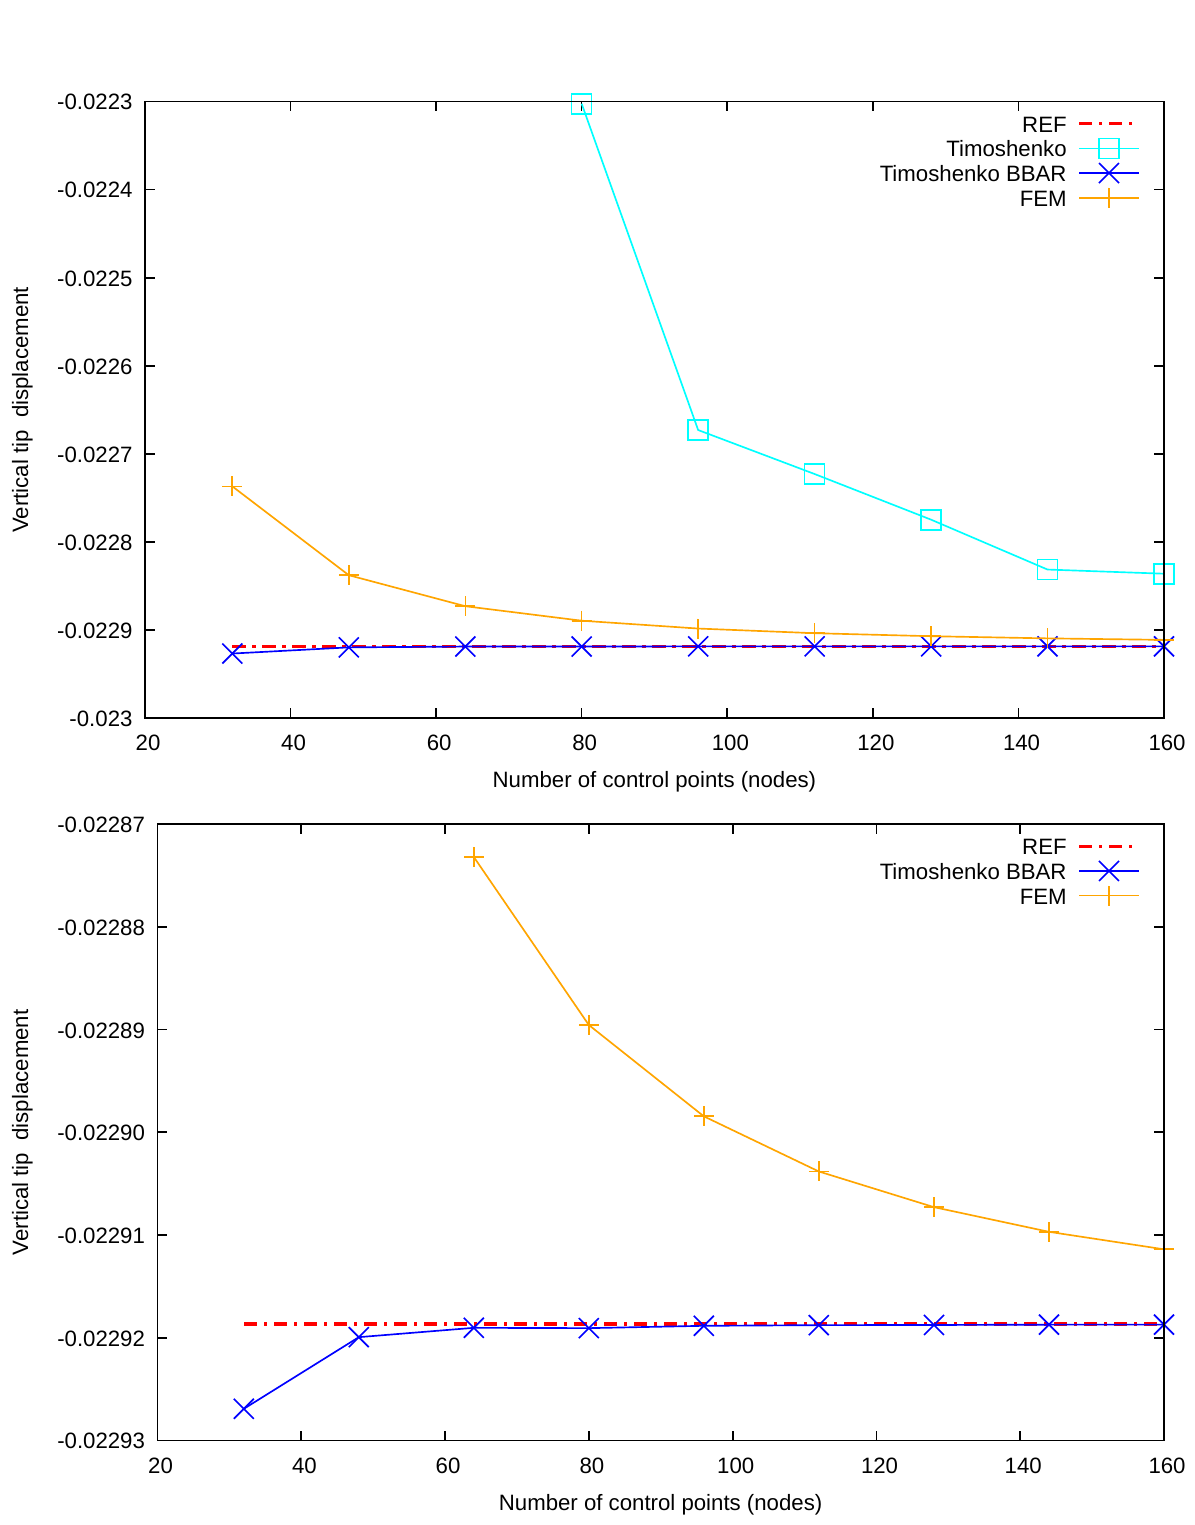
Figure 6. Comparison of Timoshenko beam element with no locking treatment with Timoshenko beam element using ¯ B -method and with naturally locking-free standard FEM beam element. The vertical axis corresponds to the vertical tip displacement w , the horizontal axis corresponds to the number of nodes (control